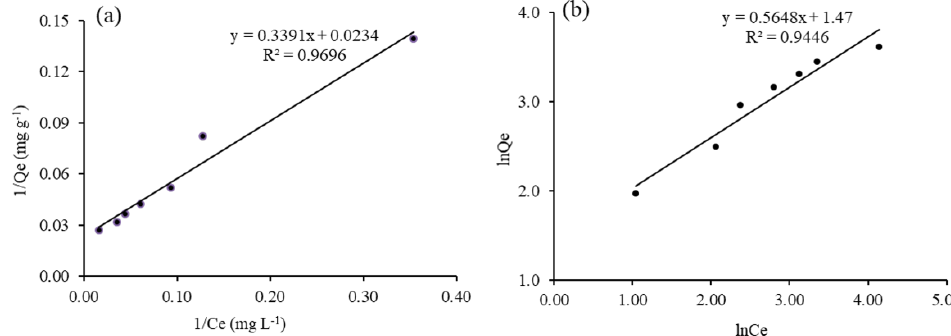
Figure 10a. Qm and K ads for 0.1Fe-TiO 2 -300 are calculated as 42 mg g -1 and 0.0079 L mg − 1